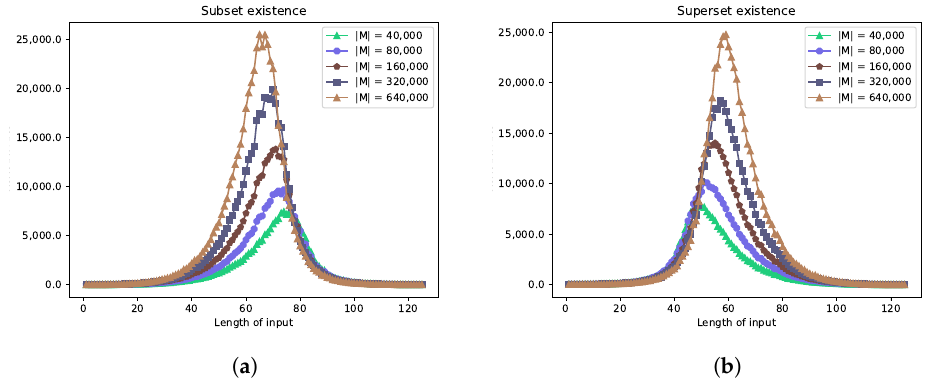
Figure 6. Existence functions in Experiment 2. ( a ) submsetExistence; ( b ) supermsetExistence. The peaks are shifted from the center to the left and right for SUBMSET E XISTENCE and SU - PERMSET E XISTENCE , respectively. Such behavior was previously observed in Experiment 1.